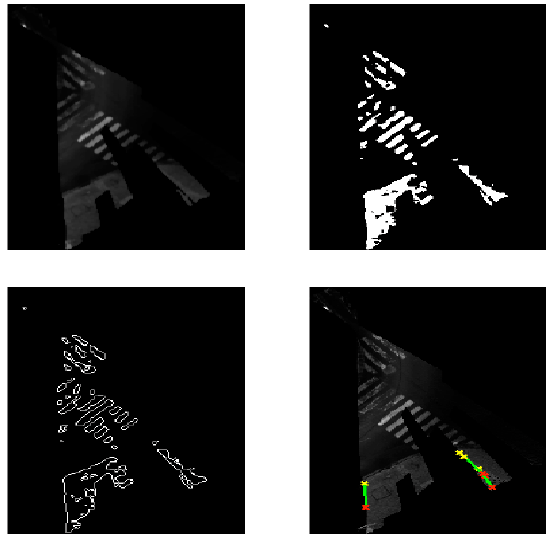
Figure 12. Malfunction of the algorithm due to occlusions of the point